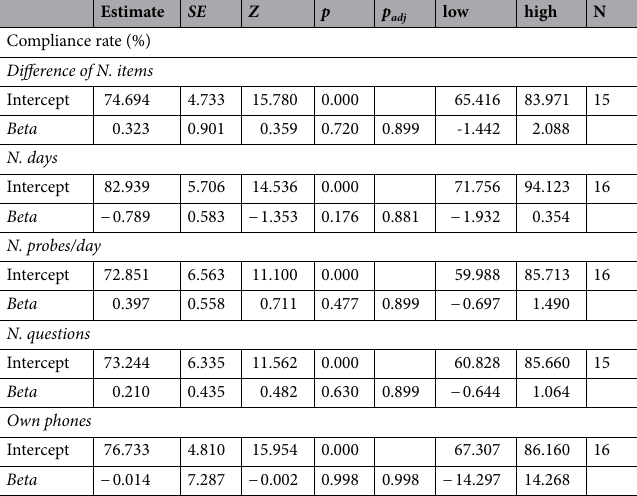
Table 3. Meta-regression results regarding compliance rate. Difference of N. items , Differences in the number of questions asked between scenarios when MW exists and when it does not. N. days Number of days (Experiment duration), N. probes/day Expected number of probes per day, N. questions Expected number of questions.